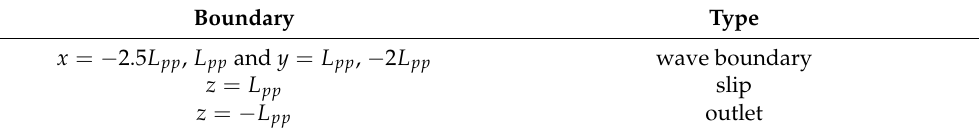
Table 2. Boundary